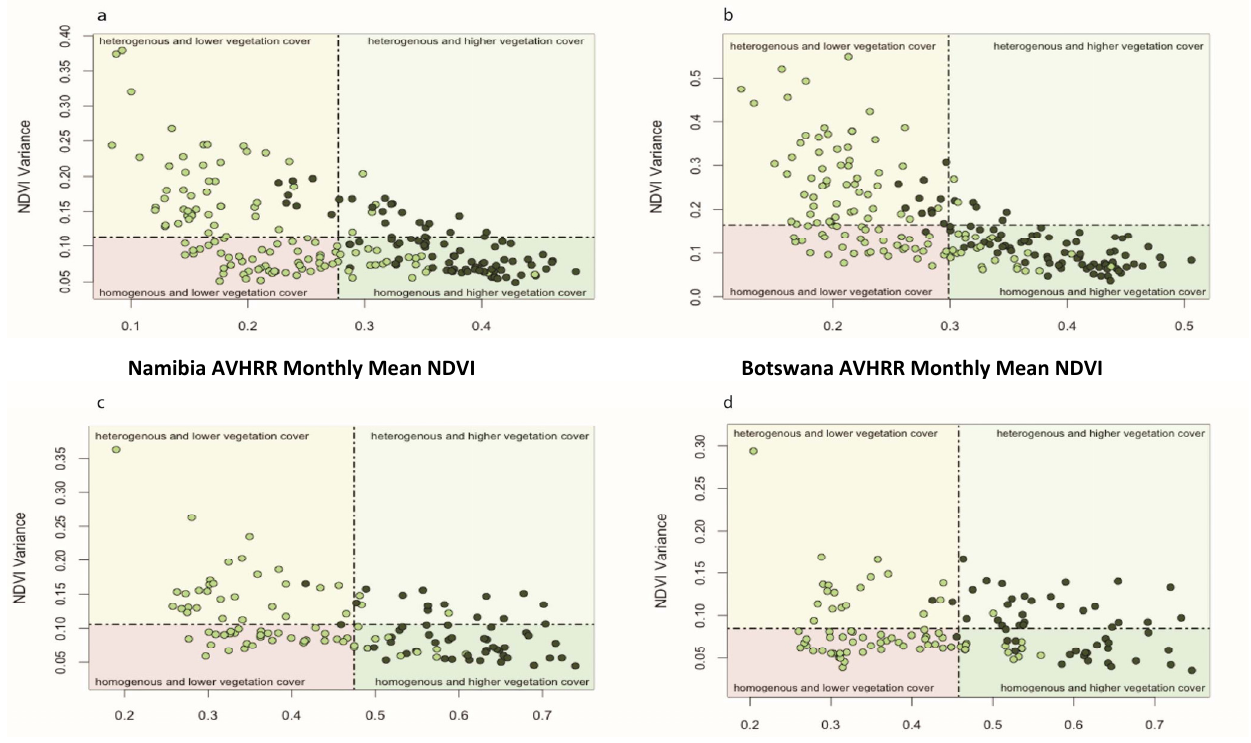
Figure 5. Mean-variance plots of monthly MVC NDVI data for subsets of the communal lands in Botswana and Namibia both for the 1985 to 2004 (AVHRR-based ( a , b )) and the 2000 to 2010 (MODIS-based ( c , d )). The dotted lines in both graphs indicate the long-term mean MVC NDVI value and mean variance respectively and are used to create the four vegetation dynamics sectors proposed by Washington-Allen et al. [35]. Dark green symbols indicate the main crop-growing season months (December–April), while light green symbols indicate the months that fall outside the main growing